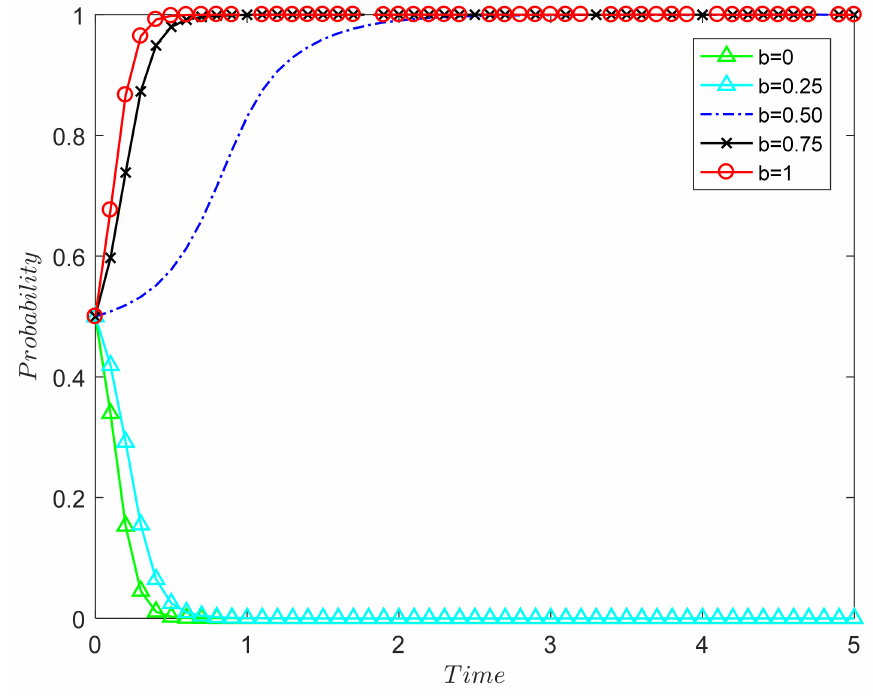
Figure 4. System evolution trajectory under different corporate leadership b